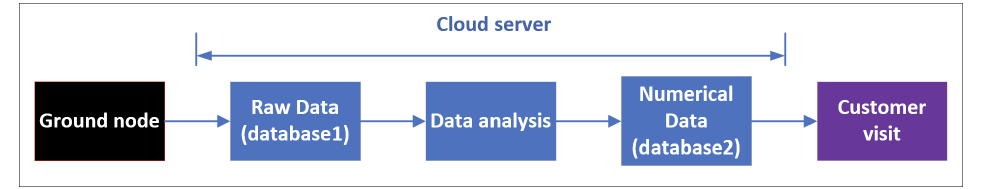
Figure 8. TM and DT data flow.